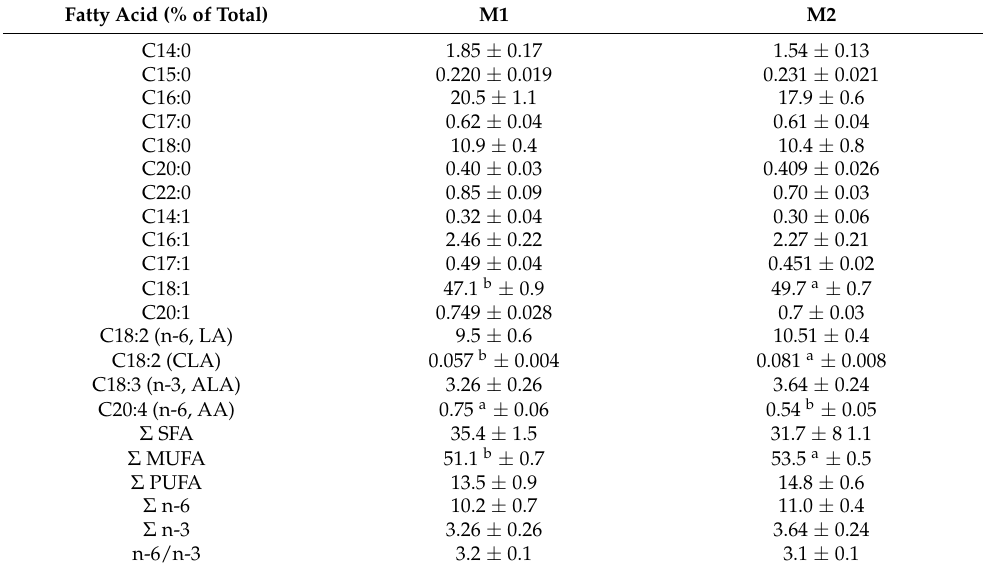
Table 3. Comparison of fatty acid composition (% of total fatty acids) of sous-vide (SV) beef marinated using M1 (Old Polish) and M2 (Bordeaux) marinades (mean values ± standard error of the mean). Fatty Acid (% of Total) M1